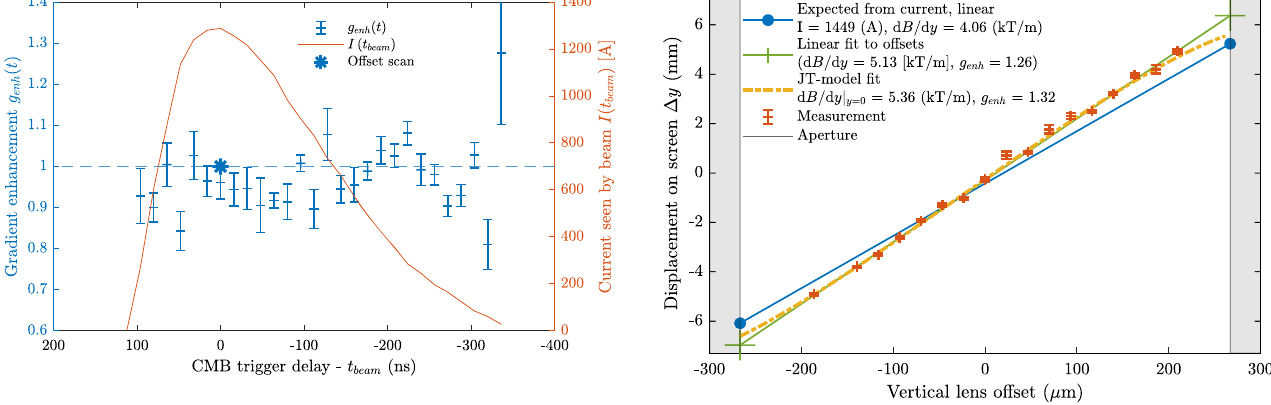
FIG. 7. Beam displacement as a function of lens offset in helium on peak current, for measuring the field